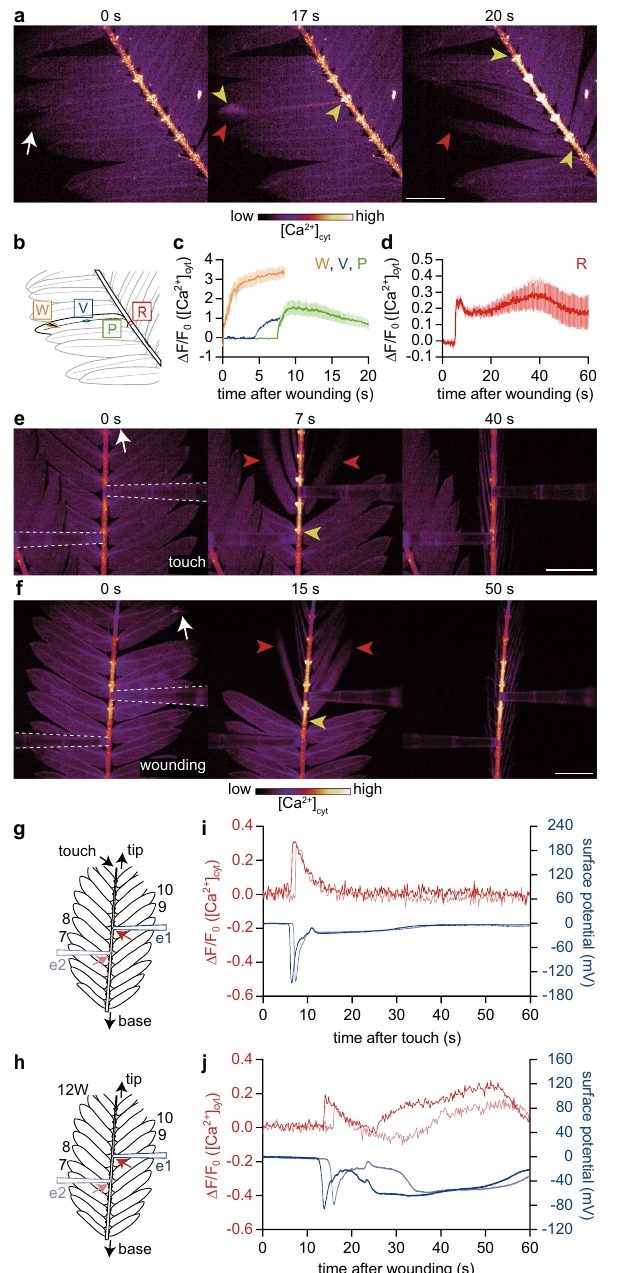
Fig. 2 | Touchand wounding trigger long-distance rapid [Ca 2+ ] cyt and electrical signals.a Woundingbyscissors(whitearrow,0s)causeda[Ca 2+ ] cyt increasethatwas transmitted through lea fl et veins and rachillae (yellow arrowheads), leading to pul- vinarmovements(redarrowheads). b Diagramoftheleafwiththeregionsofinterest (ROIs) for [Ca 2+ ] cyt analysis. W, wound site; V, lea fl et vein; P, tertiary pulvinus; R, rachilla. c , d [Ca 2+ ] cyt changes monitored in the W, V, P ( c , n =6), and R regions ( d , n =10).The Δ F/F 0 curveswereterminatedatthetimepointsatwhichROIsonWor V could not be traced because of lea fl et movements. Mean ± SEM values are shown. e , f Simultaneous recording of [Ca 2+ ] cyt increases (yellow arrowhead) and electrical signalsandlea fl etmovements(redarrowhead)causedbytouch( e )orwounding( f )as indicated by white arrows (0s). g , h Electrodes (e1 and e2, blue rectangles) and ROIs (red arrows, 1mm from the electrodes) were set on the rachilla for surface potential measurement and [Ca 2+ ] cyt analysis, respectively. A pair of lea fl ets was numbered fromthebaseofapinna.Thetipofaleafpinnawastouchedbyforceps( g ),orlea fl et number 12 was wounded with dissecting scissors ( h , W). i , j Changes in [Ca 2+ ] cyt and surface potential in response to touch ( i ) or wounding ( j ) (colors as depicted in g or h ). Scale bars,